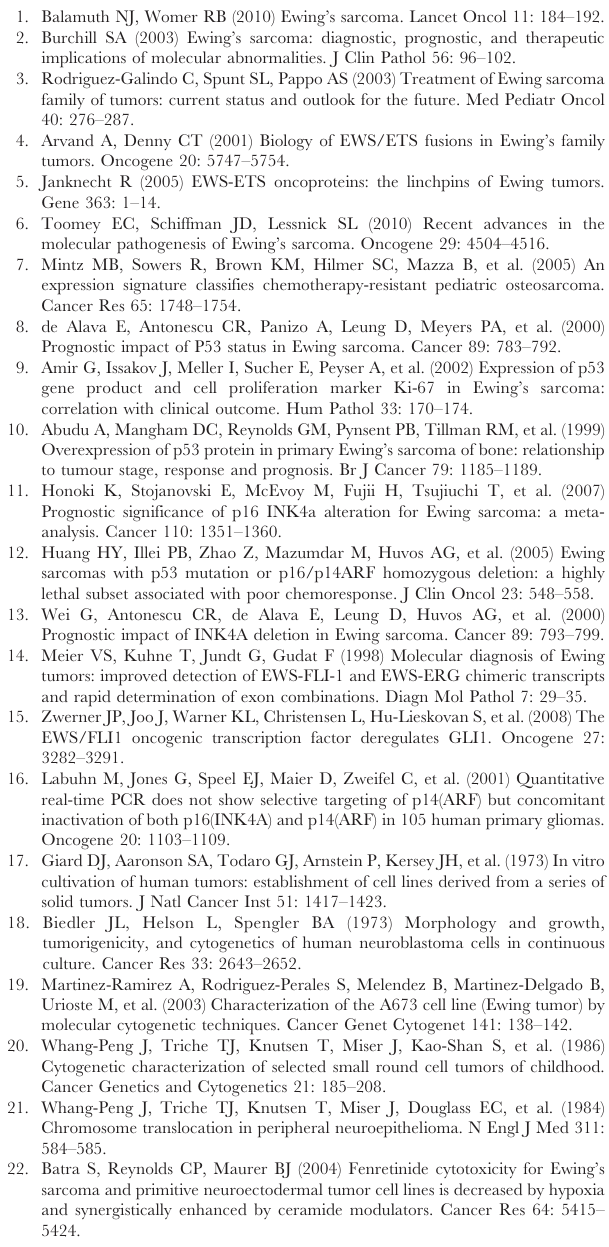
Figure S1 Fractional cytotoxicity of EFT cell lines treated with irinotecan as SN-38 (0–24 ng/ml) and vincristine (VINC: 0–200 ng/ml). Figure S2 Fractional cytotoxicity of EFT cell lines treated with melphalan (L-PAM: 0–10 m g/ml) and eto- poside ETOP (0–10 m g/ml). Figure S3 Fractional cytotoxicity of EFT cell lines treated with topotecan (TPT: 0–100 ng/ml) and doxoru- bicin (DOX: 0–30 ng/ml).